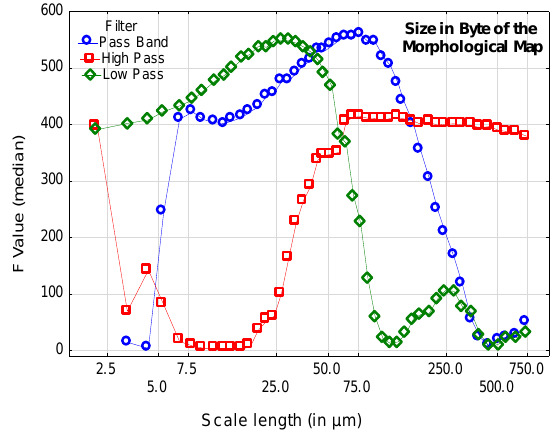
Figure 9. F median plots of the one factor ANOVA (factor: 6 surface categories) versus the scale (in µm) for the 3 filtering methods (band pass, high pass, and low pass). Table 2. Statistics of maximal F values for the three filtering methods (see Figure 9).